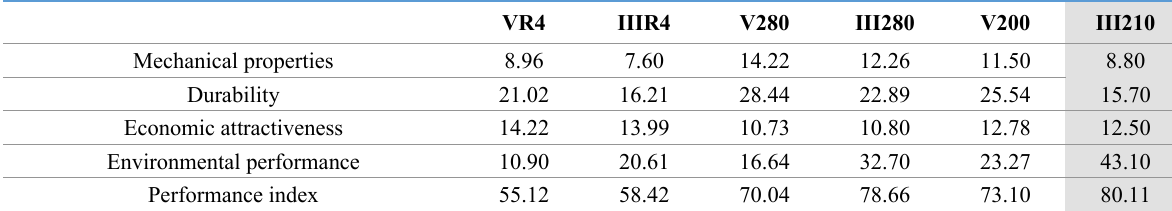
Table 12. Final Performance Index (Scenario 3 - Foundation